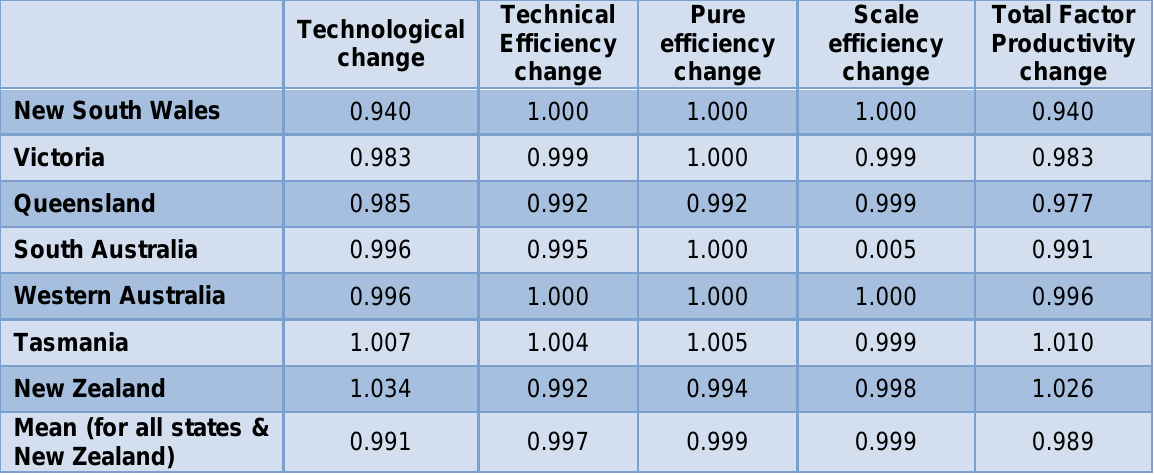
Table 6 Total Factor Productivity change, Australia and New Zealand, 1990 to 2010